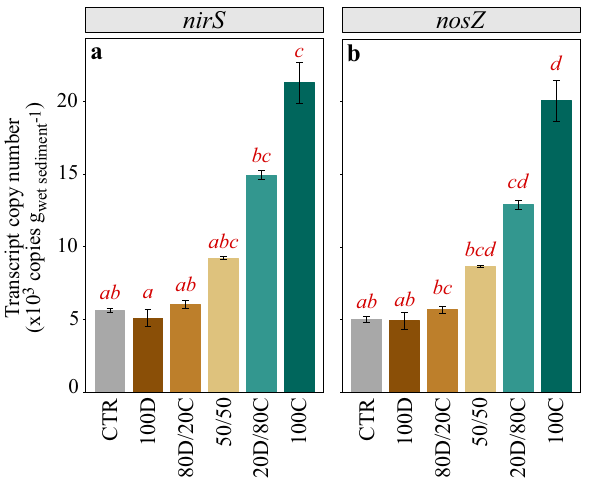
Figure 5. Transcript abundance of the ( a ) nirS and ( b ) nosZ genes, involved in denitrification (mean ± SE). Transcripts were quantified by real-time quantitative PCR on RNA samples obtained upon experiment termination, and are displayed as gene copy number per g (wet weight) of sediment. Red letter codes designate the significant differences across treatments for each gene based on Kruskal–Wallis and Dunn post-hoc test results. See Fig. 6 for labels on the